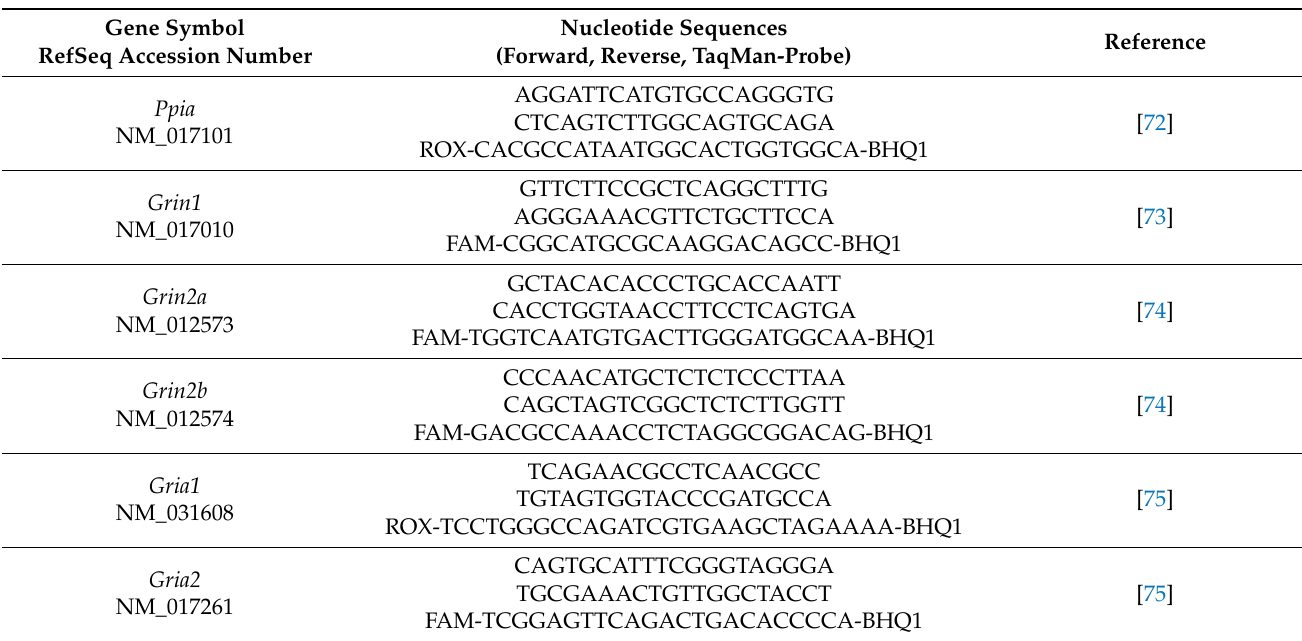
Table 1. Primers and probes used in